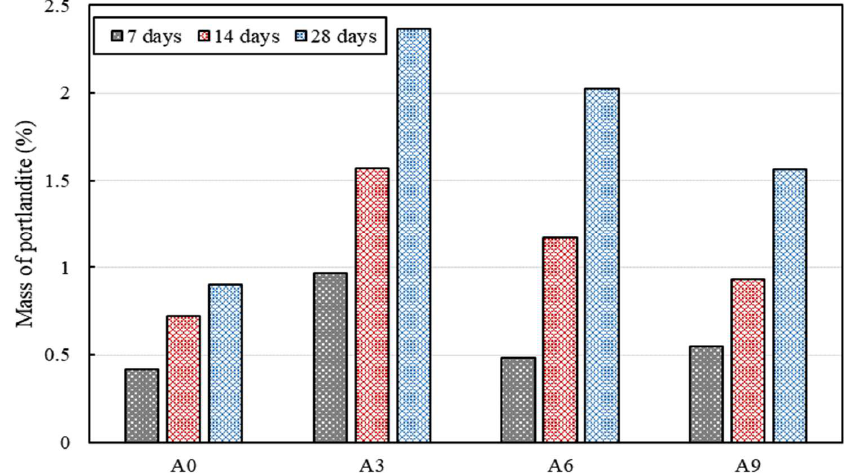
Figure 6. Mass of portlandite in the paste specimens on the 7th, 14 th , and 28th days, quantified from TG results.